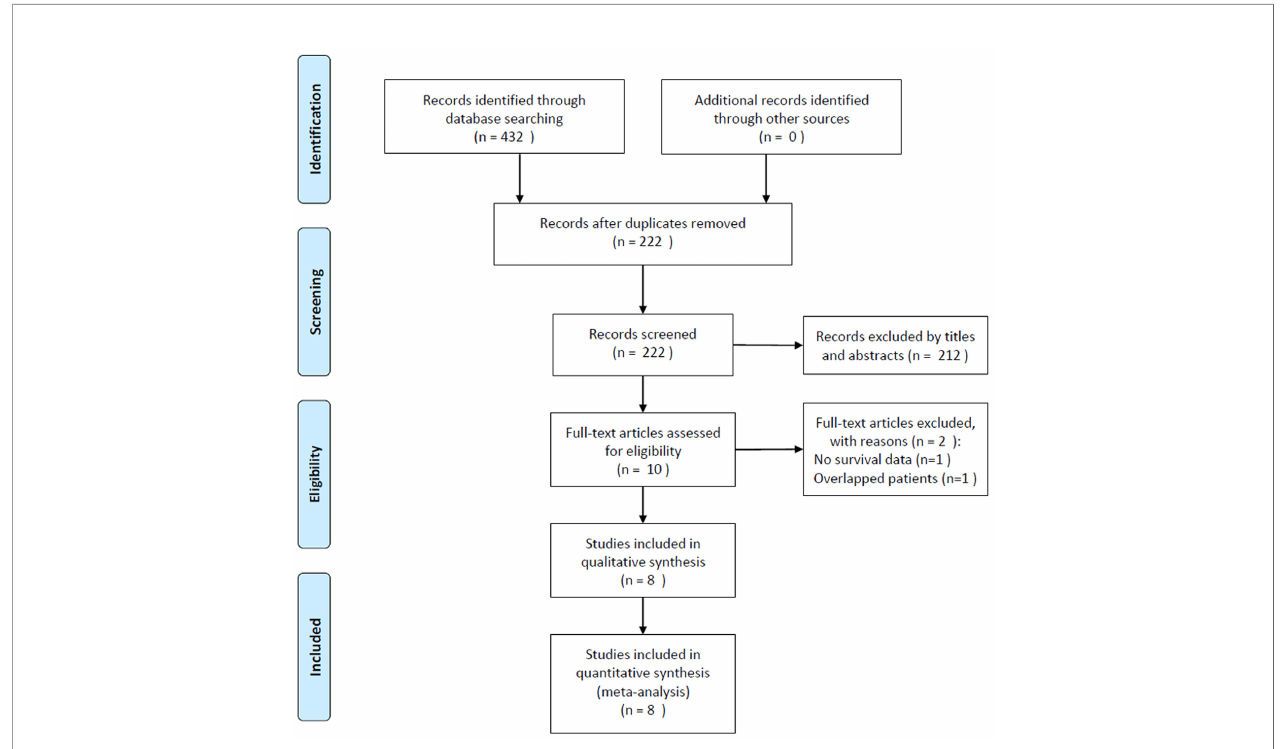
FIGURE 1 | Flow diagram of included studies for this